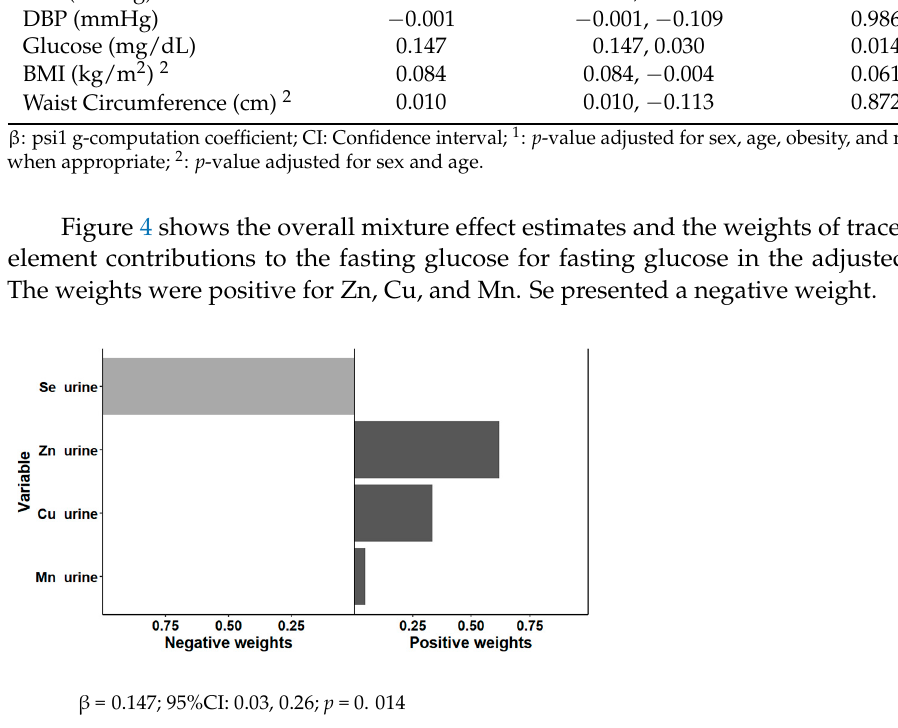
Figure 4. Overall mixture effect estimates (psi1 beta coefficients, 95% confidence intervals, and p- values) and the weights of trace elements contributions to the fasting glucose l levels for the combined association with urine Zn, Cu, Se, and Mn. Adjusted